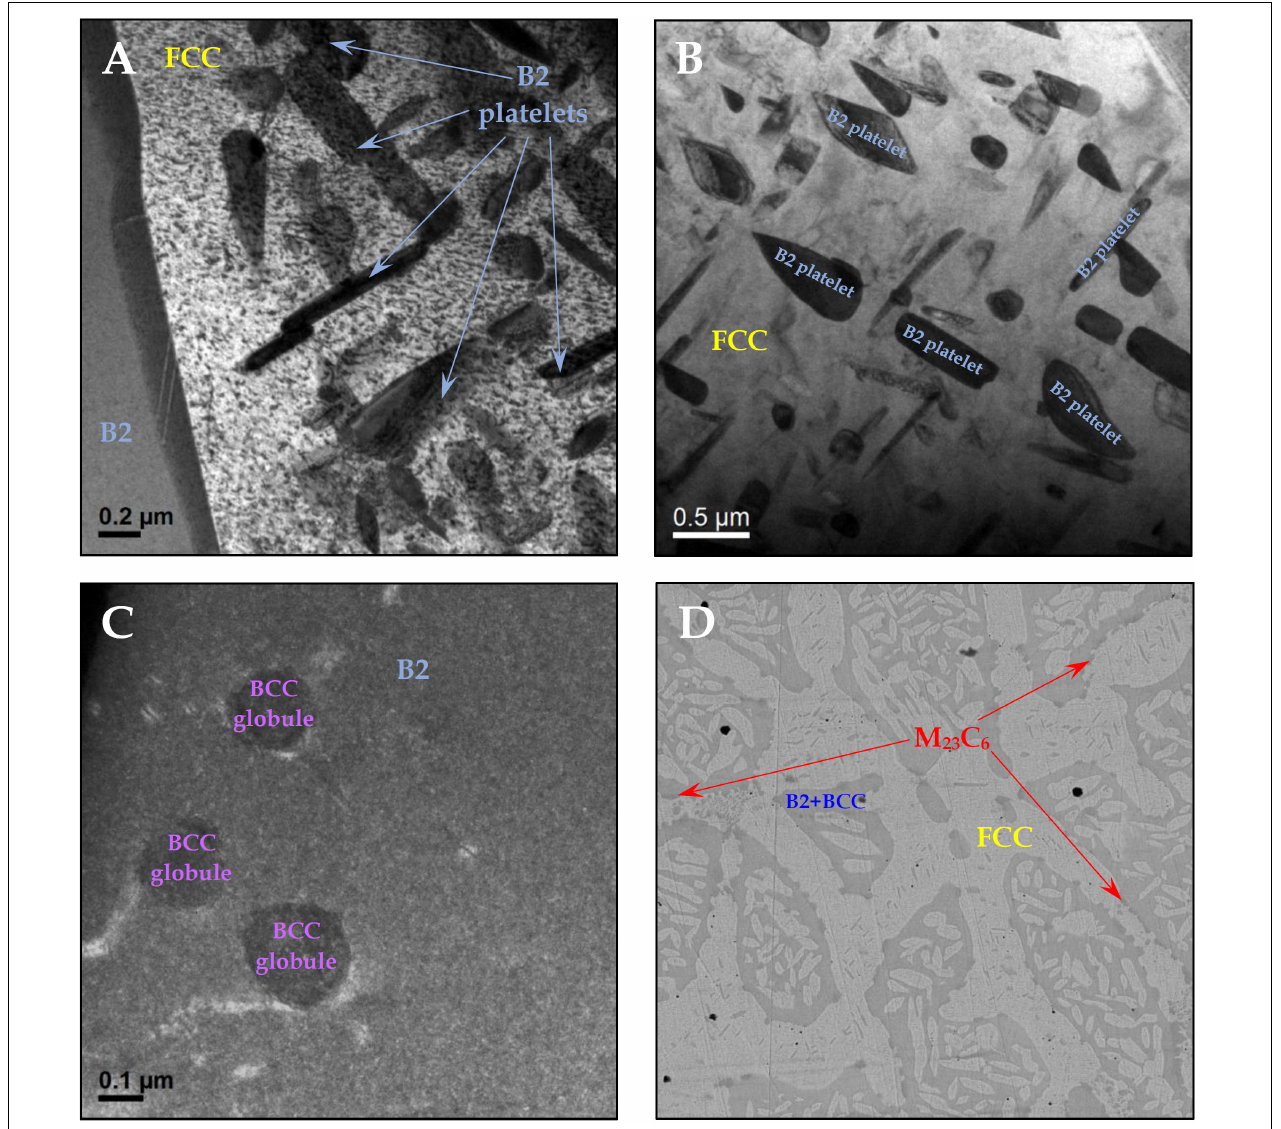
FIGURE 13 | (A–C) BF-TEM micrographs showing the general morphology of the phases and precipitates comprising the microstructure of the homogenized and aged (930 ◦ C) AlCrFe 2 Ni 2 alloy; (D) HRSEM micrograph showing the general microstructure in aged (930 ◦ C) AlCrFe 2 Ni 2 alloy.